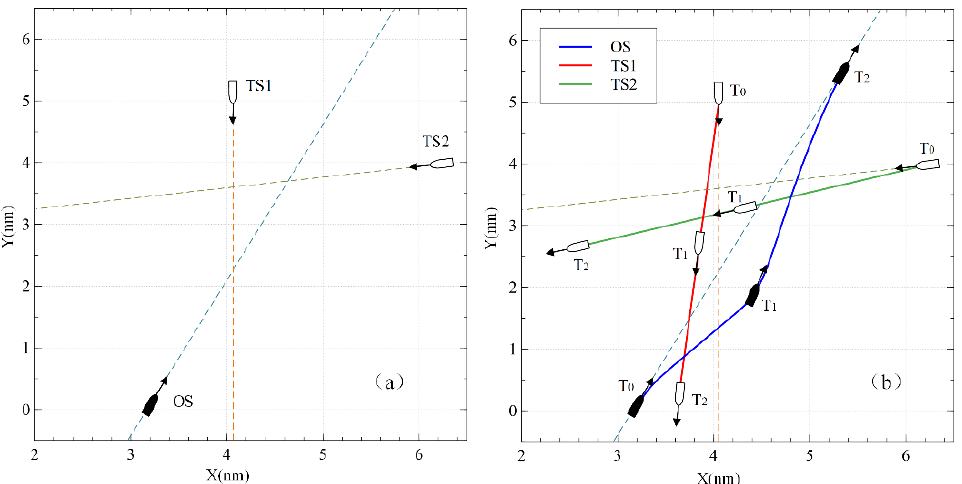
Figure 10. The ships’ trajectories under three ships encounter situation: ( a ) initial positions and paths; ( b ) trajectories of three ships.